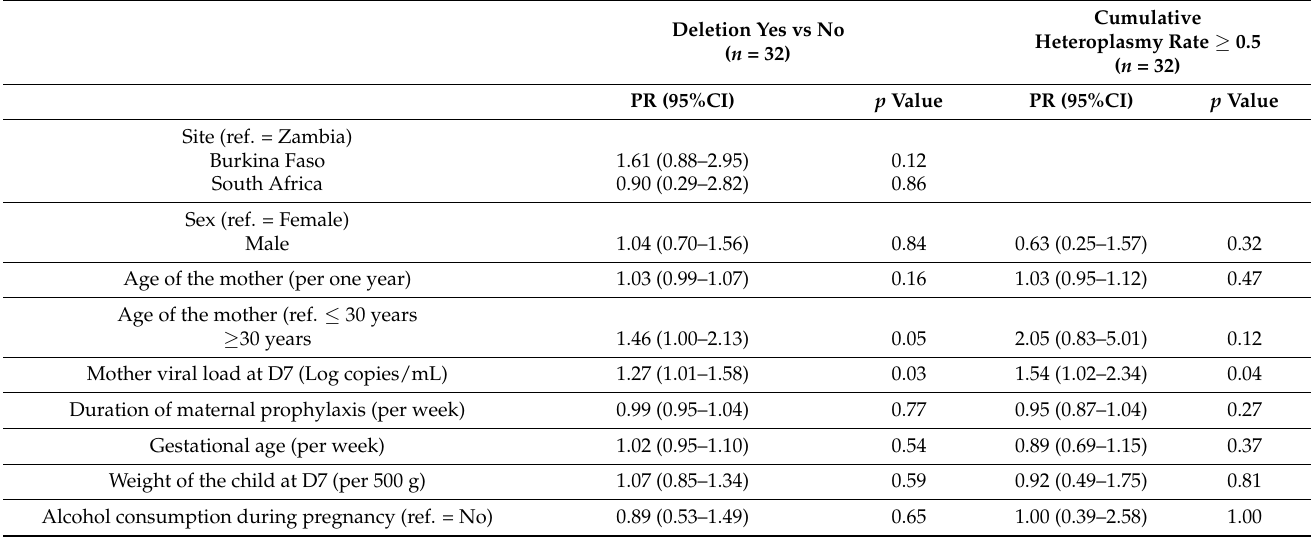
Table 2. Predictive factors for mitochondrial